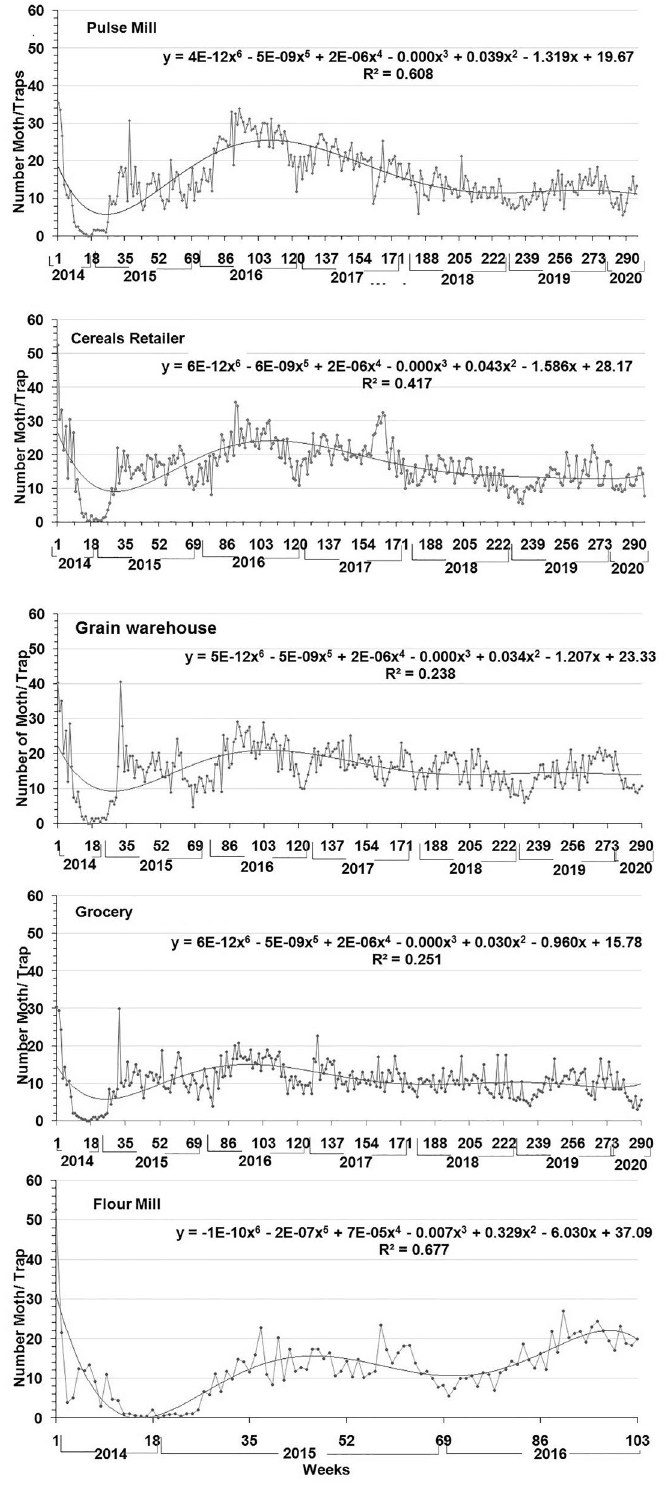
Figure 1. Mean number of P. interpunctella adultscaptured in pheromone traps at different food facilities in Rajshahi municipality area during the period from September 2014 to March